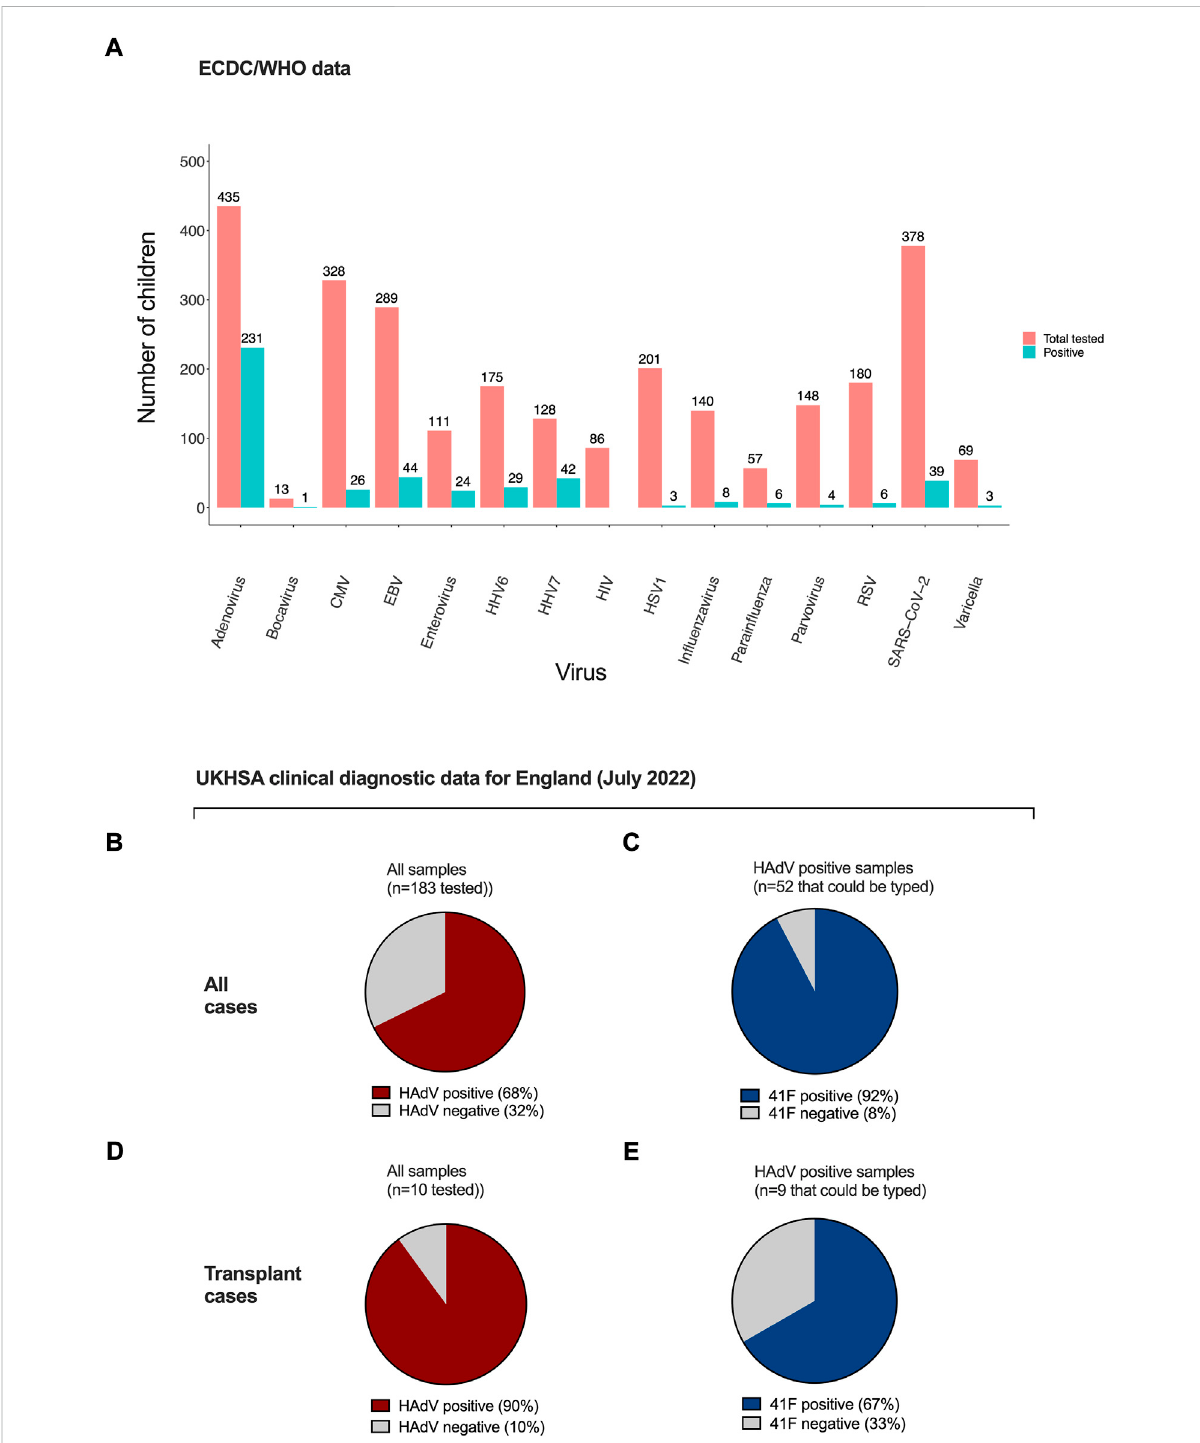
FIGURE 5 Rate of positivity for viruses among tested samples by ECDC and in UKHSA. (A) ECDC/WHO data for 513 samples indicating number tested and numberpositive(ECDC,2022d).PanelsB,C,D,EshowUKHSA datareportedinTechnical Brie fi ng4(UKHSAInvestigationintoacutehepatitis,2022). Proportionof samplestestingpositive for HAdVinall AS-Hep-UA cases (B) andchildren undergoingtransplant (C) . Proportion ofHAdVtyping as 41F in all AS-Hep-UA cases (D) and explant tissue (E) . HAdV - human adenovirus. HHV-7 – human herpes virus 7, HHV-6c – human herpes virus